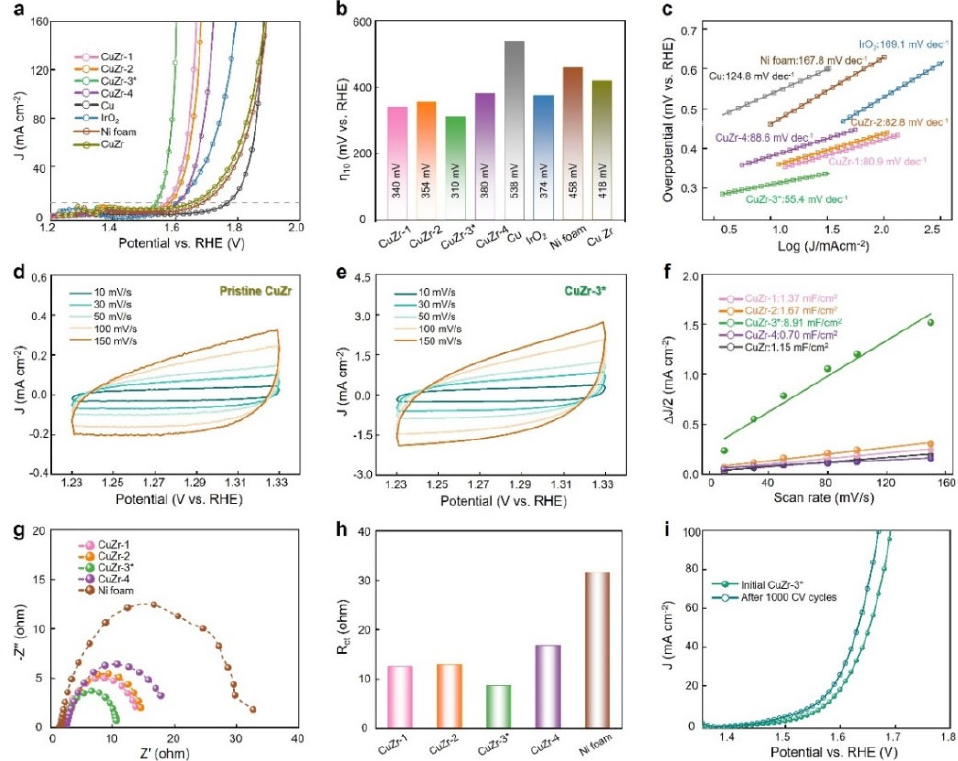
Figure 4. OER performance. ( a ) LSVs of the serial CuZr samples, Cu foil, Ni foam and IrO 2 . The corresponding ( b ) overpotentials at 10 mA cm − 2 and ( c ) Tafel slopes. ( d , e ) CV curves from 10 to 150 mV s − 1 for the pristine and CuZr − 3* samples. ( f ) The dependence of capacitive current densities with scan rates. ( g ) The Nyquist plots measured at the potentials corresponding to 10 mA cm − 2 . ( h ) The fitted value of R ct for each sample. ( i ) The LSVs of CuZr − 3* before and after accelerated durability test.